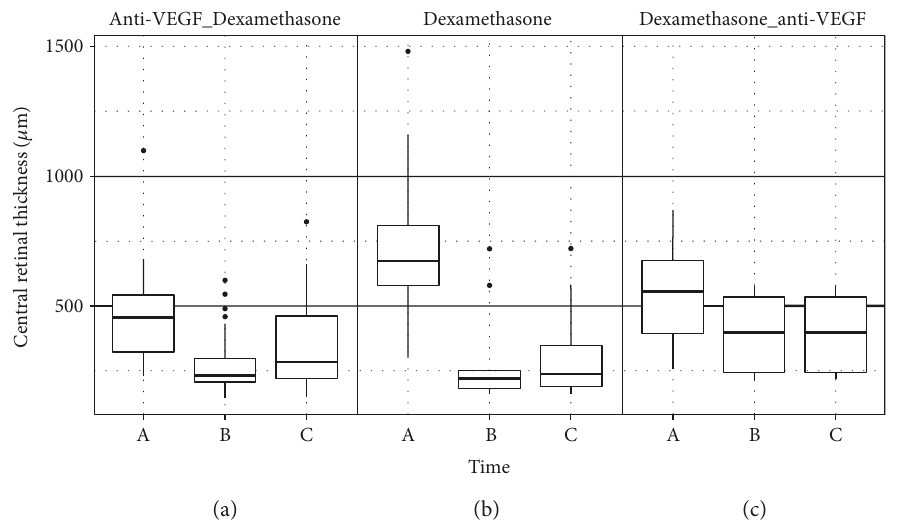
Figure 2: Mean CFT decrease was most pronounced in treatment naïve eyes ((b) from 675 μ m [580; 810] to 238 μ m [188; 348], change − 437 μ m, p = 0 002 ) compared to Anti-VEGF_Dexamethasone group ((a) from 455 μ m [323; 542] to 285 μ m [219; 460], change − 170 μ m, p = 0 003 ) and Dexamethasone_anti-VEGF treated eyes ((c) from 555 μ m [395; 675] to 398 μ m [245; 535], change − 157 μ m, p = 0 31 ). A=CFT before switch from anti-VEGF to dexamethasone (a) or vice versa (c) or before treatment (b); B=CFT at the time of the best BCVA after switch/treatment (at 88 days [70; 176], 92 days [87; 100], and 123 days [96; 210]); and C =at the end of observation (median follow-up was 4.3 months for the Anti-VEGF_Dexamethasone group, 3.1 months for the Dexamethasone group, and 6.0 months for the Dexamethasone_anti-VEGF